Question: Write a descriptive caption for this figure.
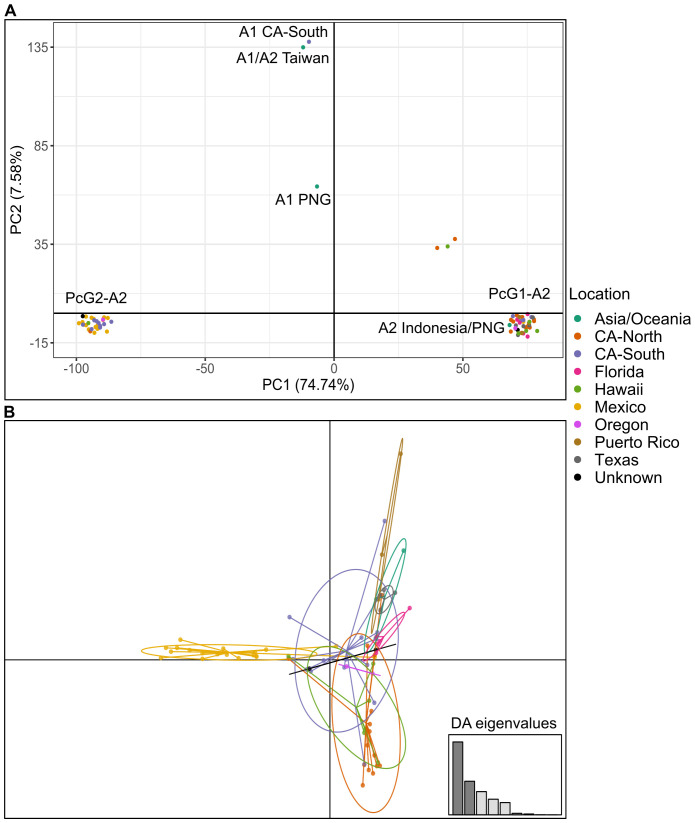
Answer: Multivariate analyses of the P. cinnamomi populations from the U.S.A. and Mexico after clone correction. (A) Principal component analysis (PCA) plot showing two principal components, in which PC1 reflects 74.74%, and PC2 reflects 7.58% of the total variation. Phytophthora cinnamomi reference isolates corresponding to the two A2 panglobal clonal lineages (PcG1-A2 and PcG2-A2), several A1 and A2 isolates from Taiwan, Papua New Guinea (PNG), and Indonesia, as well as an A1 isolate from CA-South collected from Camelia are indicated. (B) Discriminant analysis of principal components (DAPC) plot indicating the different PC groups, where the points represent the individuals and the ellipses represent the geographical locations. DA eigenvalues distribution is also displayed. Points in each plot reflect the individual by geographical location: Asia/Oceania = teal, CA-North = orange, CA-South = blue, Florida = pink, Hawaii = green, Mexico = yellow, Oregon = purple, Puerto Rico = brown, Texas = gray, and Unknown region from California = black.